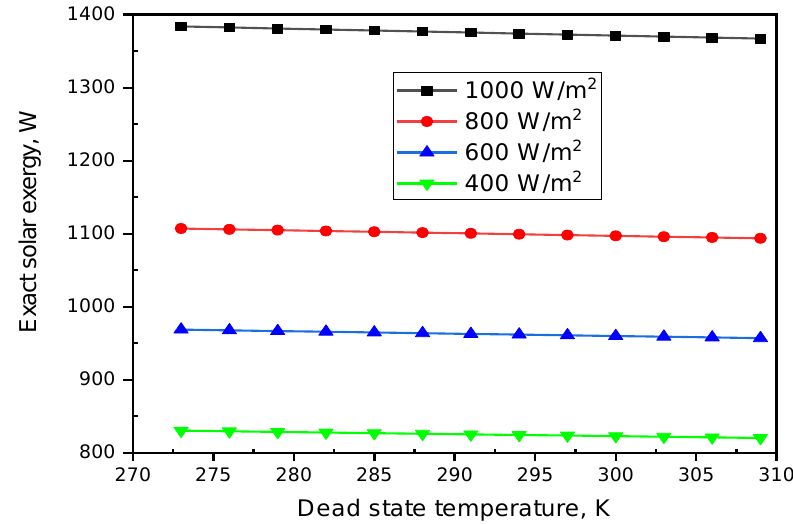
Figure 10. Effects of date state temperature on exact solar exergy coming from the sun.